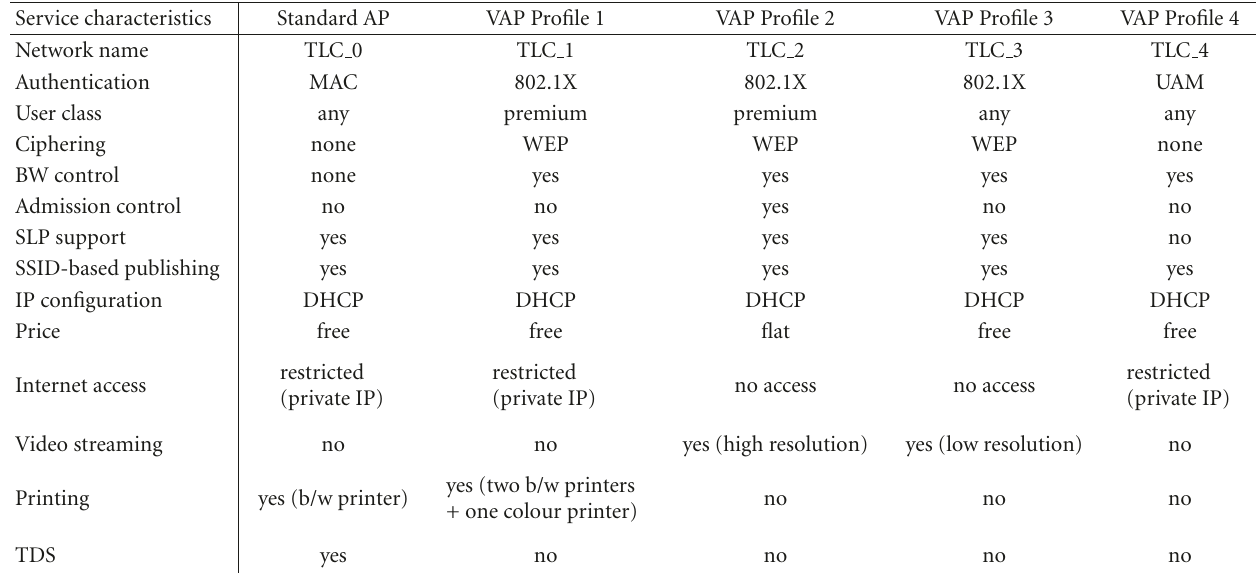
Table 1: Service o ff